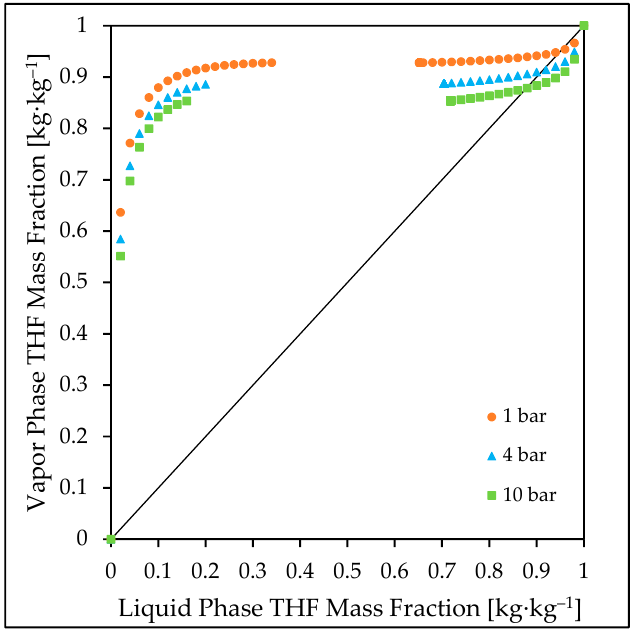
Figure 3. Vapor–liquid equilibrium graph for THF–H 2 O mixture in the pressure range of 1–10 bar, created with Aspen Plus ® using the nonrandom two-liquid (NRTL) thermodynamic model. Exemplary pressures 1, 4, 10 bar depicted with three different colors.